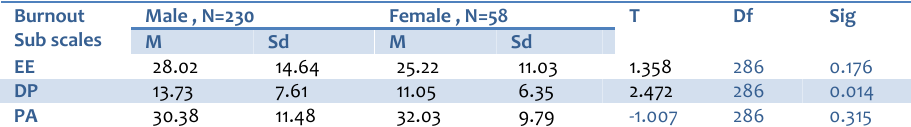
Table 6: Results of t-test on mean difference of burnout based on sex of respondents Male , N=230 Female , N=58 Burnout T Df Sig Sub scales M Sd M Sd EE 28.02 14.64 25.22 11.03 1.358 286 0.176 DP 13.73 7.61 11.05 6.35 2.472 0.014 PA 30.38 11.48 32.03 9.79